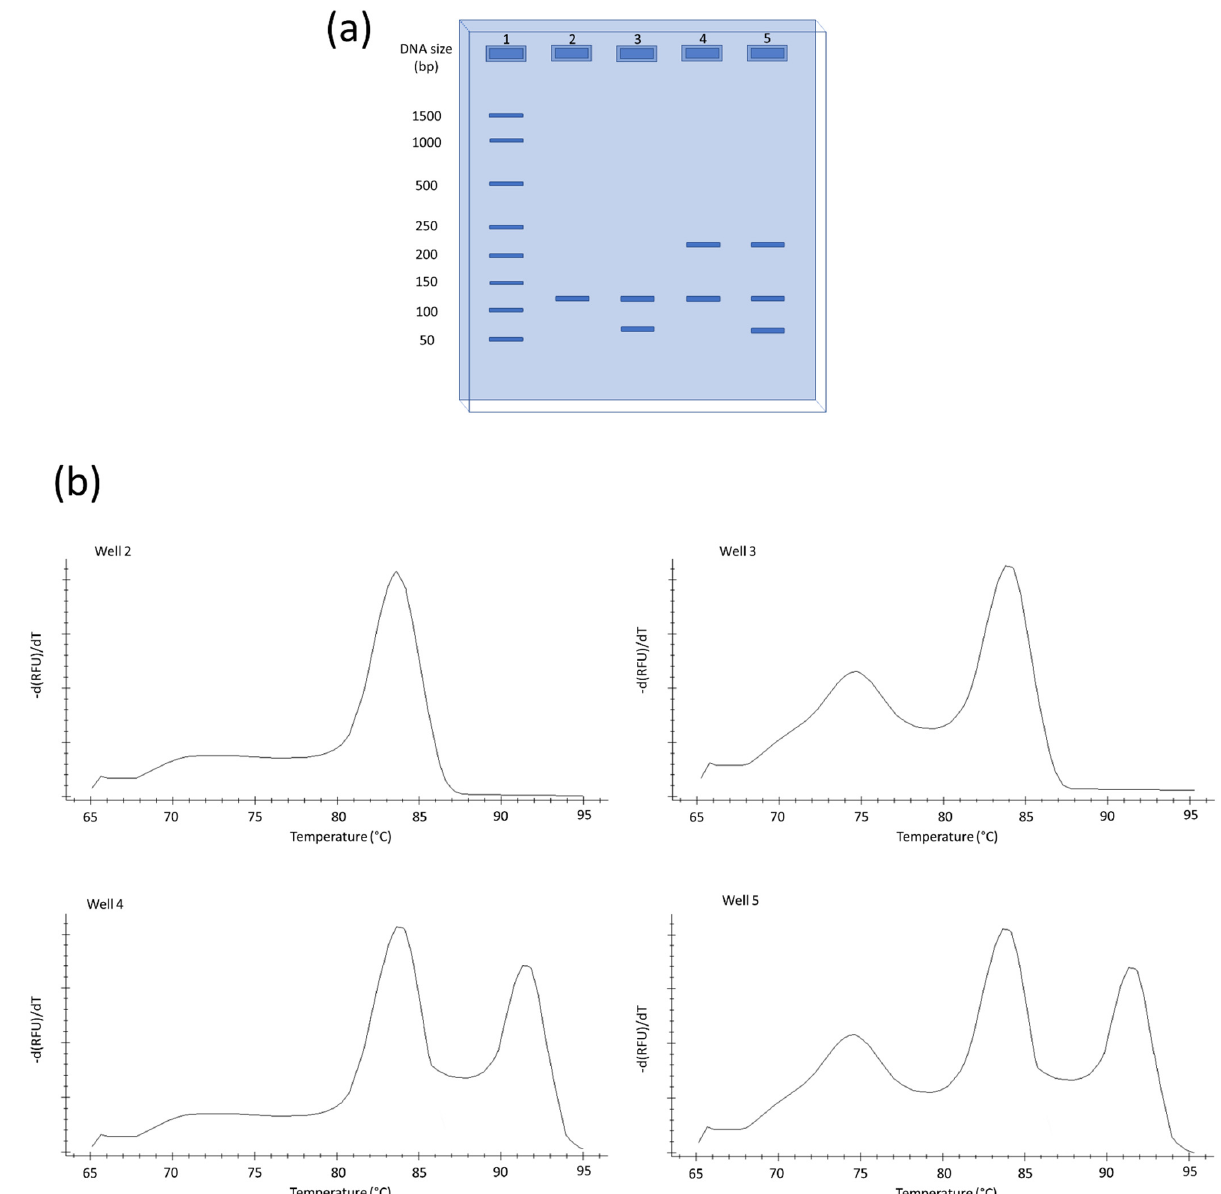
Figure 2. Correct and false PCR products shown on a schematic agarose gel (panel ( a )) and melting peaks (panel ( b )). In well 1, a DNA ladder is run, the size of the bands is on the left side of the gel. Well 2 contains the correct PCR product without any contamination. In wells 3–5, besides the correct product, there are shorter and/or longer false products derived from mispriming or primer dimers. The melting peaks are derivatives of melting curves obtained during melting point analysis.